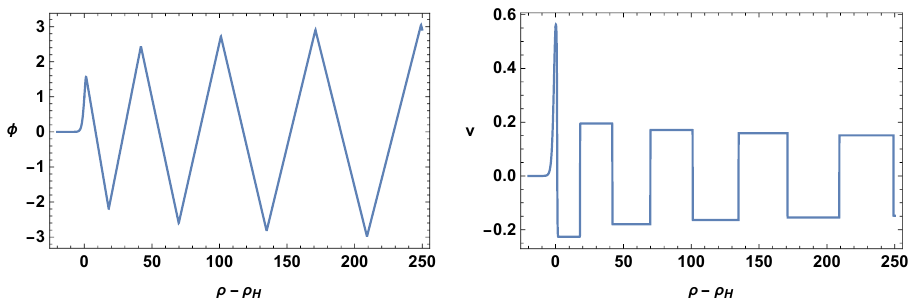
Figure 1: Evolution of φ (left plot) and v = ˙ φ (right plot) as a function ρ . The AdS boundary is at ρ → −∞ , the horizon at ρ = ρ Numerics have been performed with the potential V = − 6 − φ 2 + 1 Towards the boundary φ ∼ ˙ φ ∼ e ρ . The constants of integration have been fixed by regularity at the horizon combined with φ ( ρ super-exponential potential is delicate. We have found it most convenient to integrate the original equations (5) – (7), converted to the ρ coordinate. See e.g. [ 11 ]